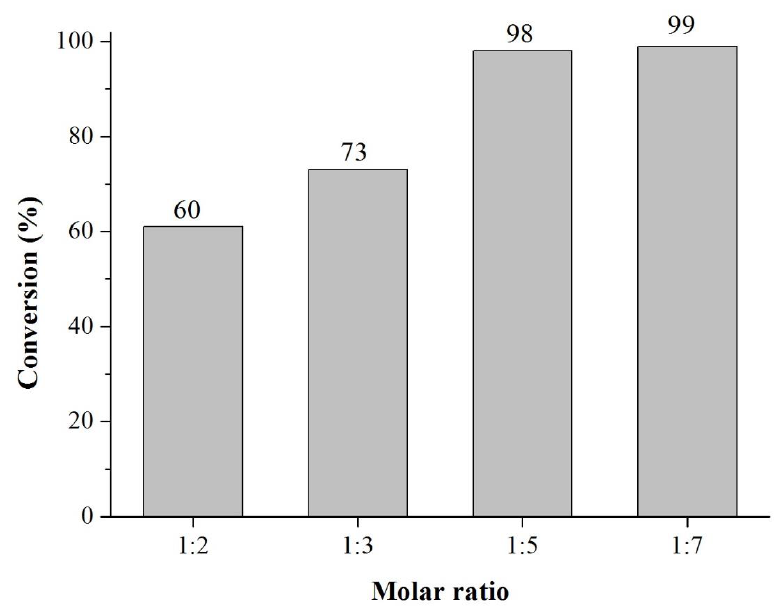
Figure 8. Percentage conversions of eugenyl acetate with different molar ratio of eugenol: acetic anhydride. Reaction conditions: reaction temperature 80 °C and reaction time 40 min and 2% catalyst.